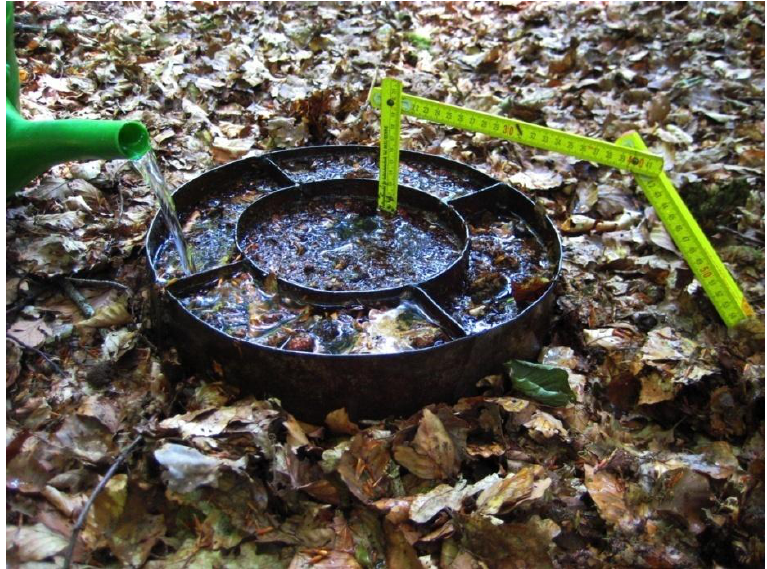
Figure 5. Double-ring infiltrometer during a